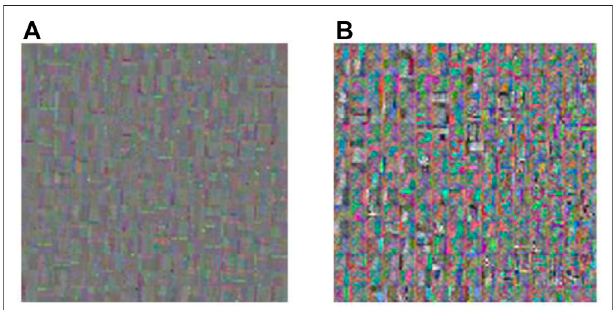
FIGURE7| Dictionary obtained byK-SVD andK-GASVD. (A) Dictionary obtained by K-SVD algorithm (B) Dictionary obtained by K-GASVD algorithm.